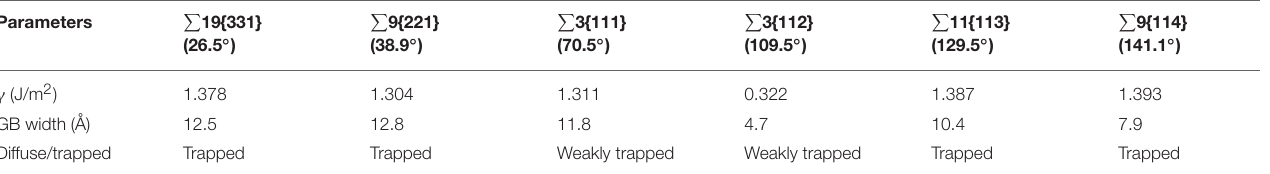
TABLE 2 | Parameters for six models and their corresponding behavior. Parameters